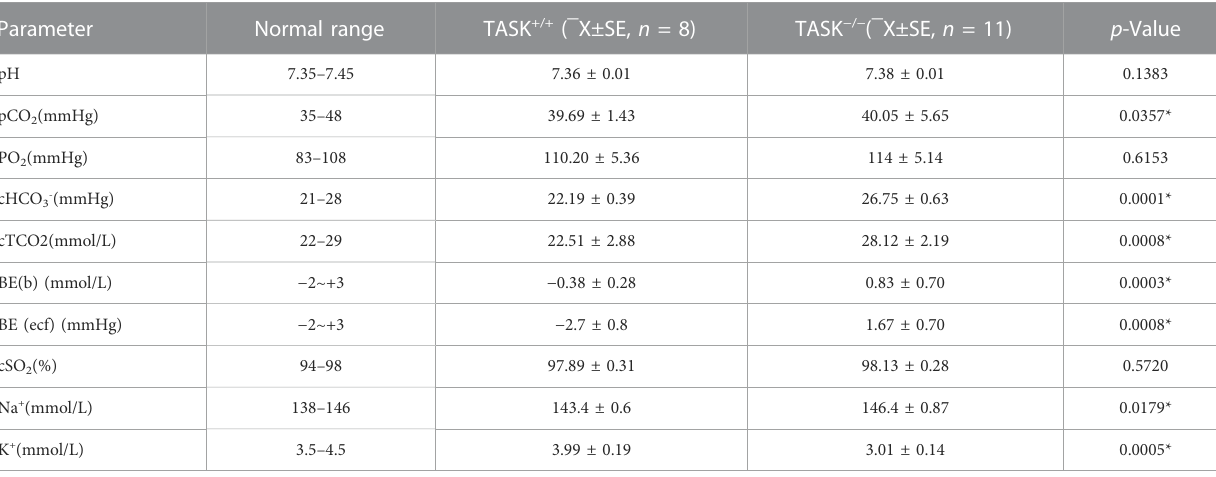
TABLE 1 Electrolytes/chemistries/blood gases.